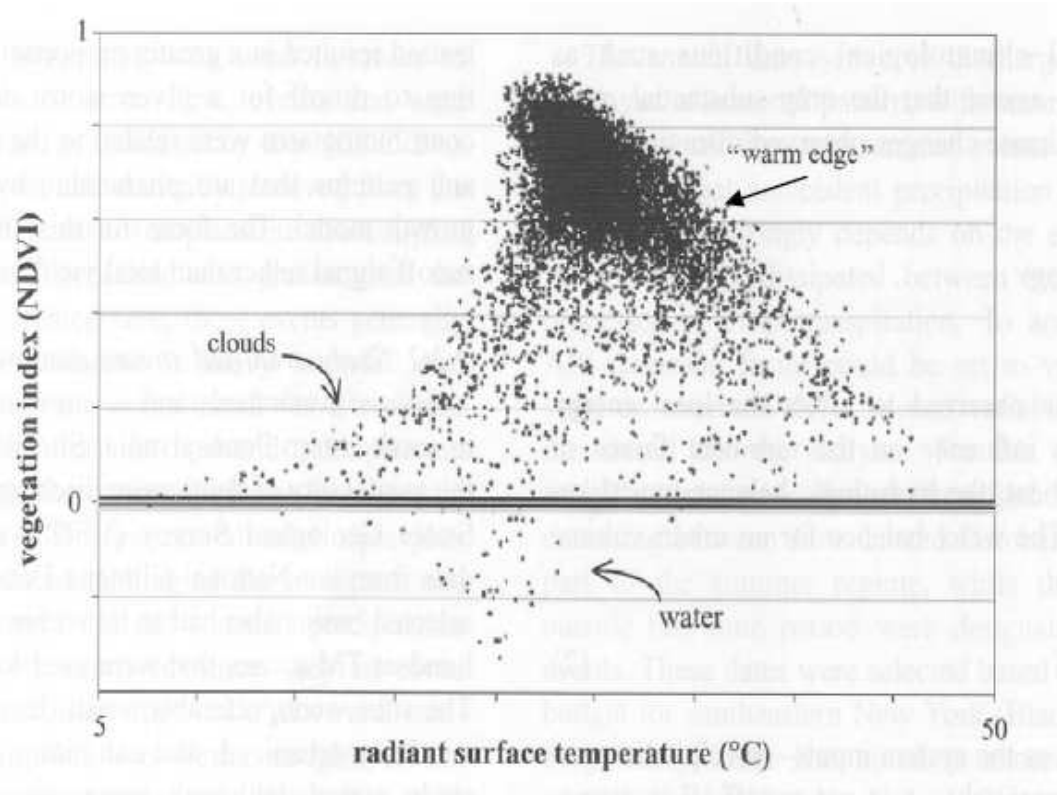
Figure 1. Scatter plot of satellite pixel values of NDVI versus radiant surface temperature from an AVHRR image approximately 100 km on a side located near Philadelphia, Pennsylvania, August 17, 1991. The warm edge, denoted with an arrow, is evident from the sharply defined right side of the pixel envelope. Pixels likely representing clouds and water are labeled with